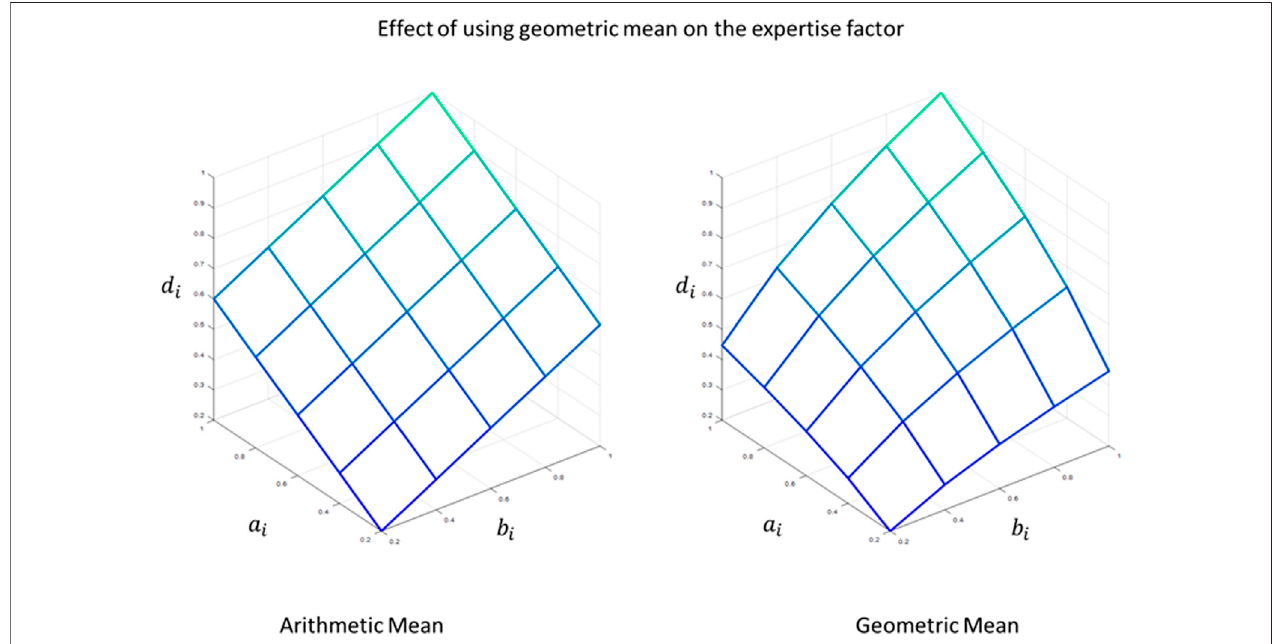
FIGURE 3 | Effect of Using geometric mean on the expertise factor, d i , for a i (cid:2) 1